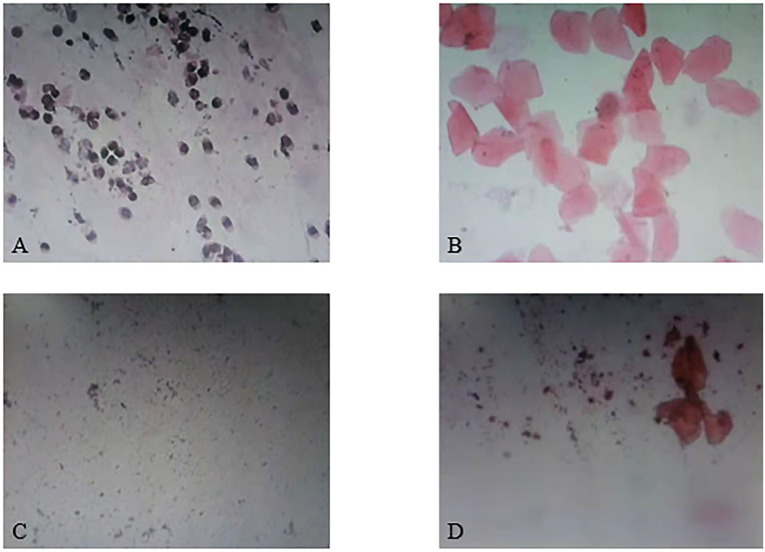
Results of vaginal smear. (A) Proestrus. (B) Estrus. (C) Diestrus. (D) Metestrus.